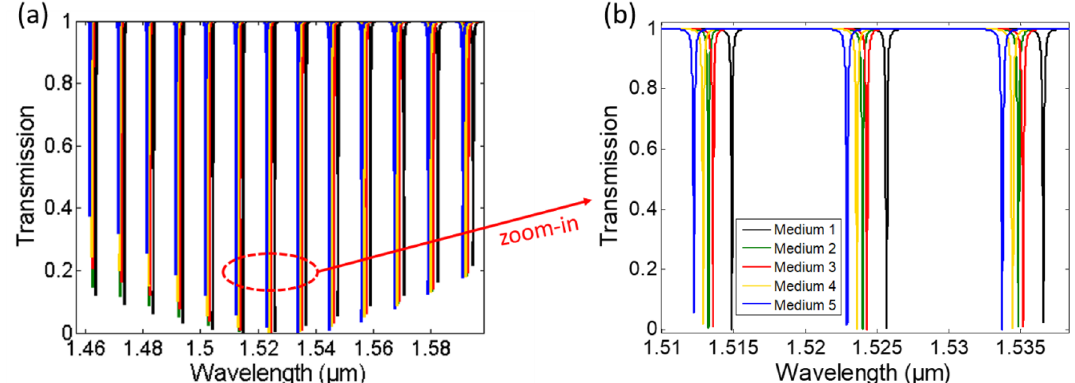
Figure 7. Transmission spectra of the five multi-element media mentioned in Table 3 ( a ) whole spectrum and ( b ) zoomed-in